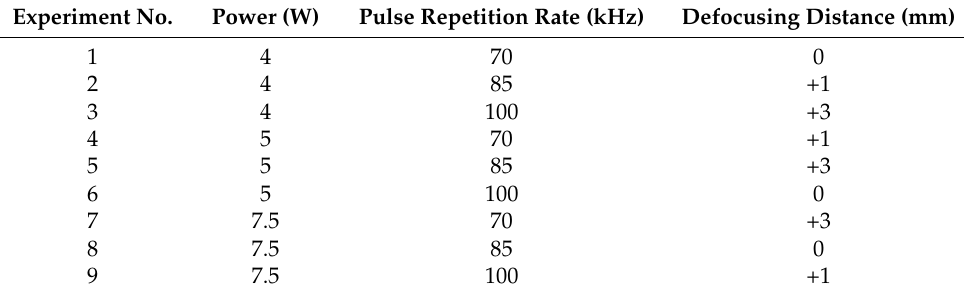
Table 2. Tabulation of levels according to L9 orthogonal array. Experiment No. Power